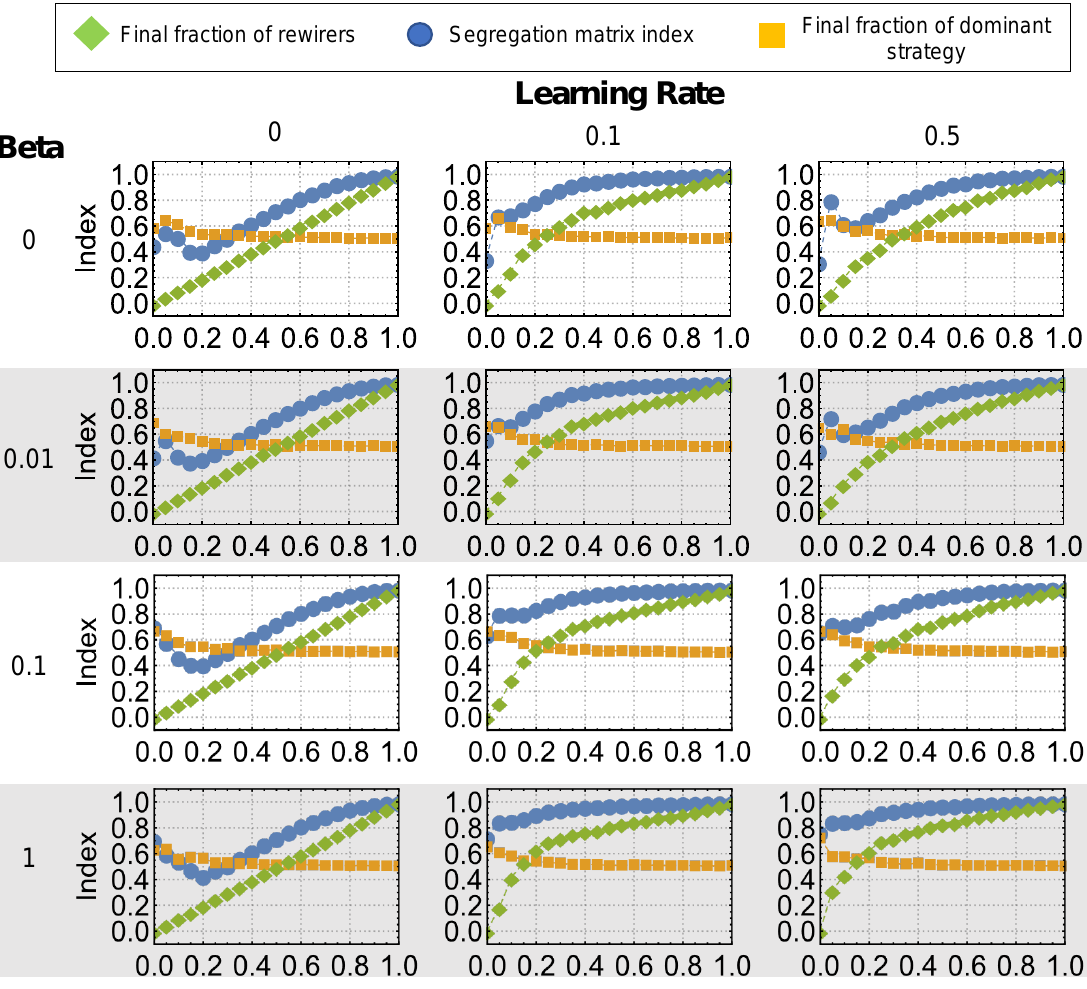
Figure 2. Panel of segregation matrix indexes (SMI) over different values of initial densities of rewirers (R0) for different values of rewiring parameter β and learning parameter ρ L . Every data point is averaged over 50 different replicates. Error bars were not reported since they are of the same size of